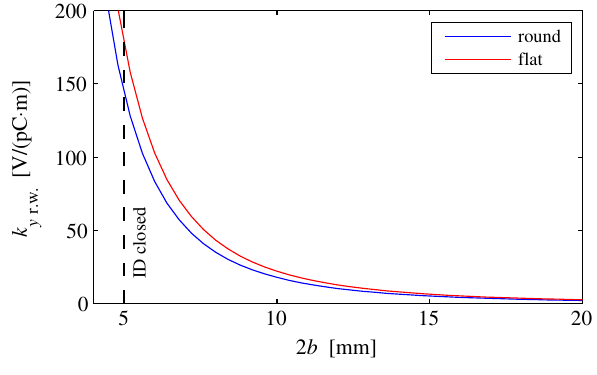
FIG. 9. Resistive-wall kick